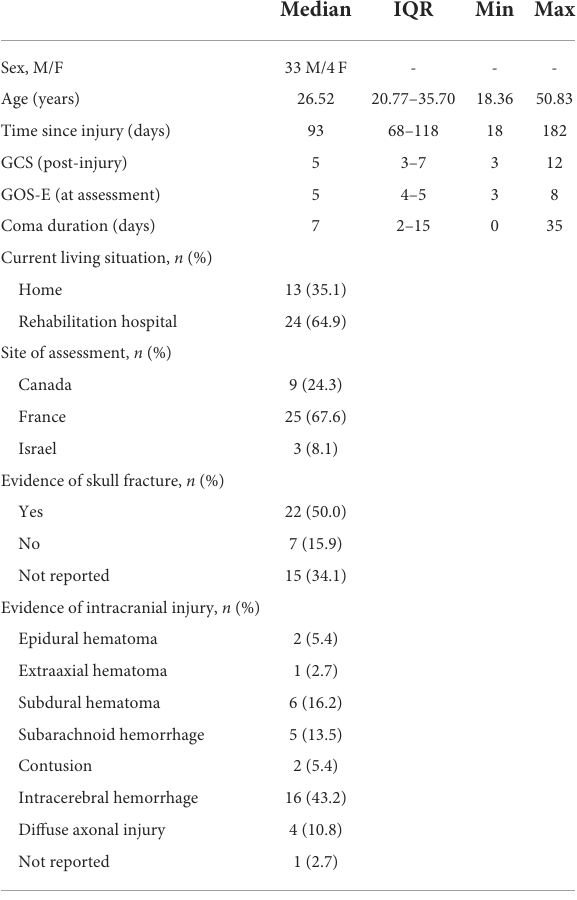
TABLE 2 Patient characteristics of adults with TBI who participated in balance testing ( n = 37).